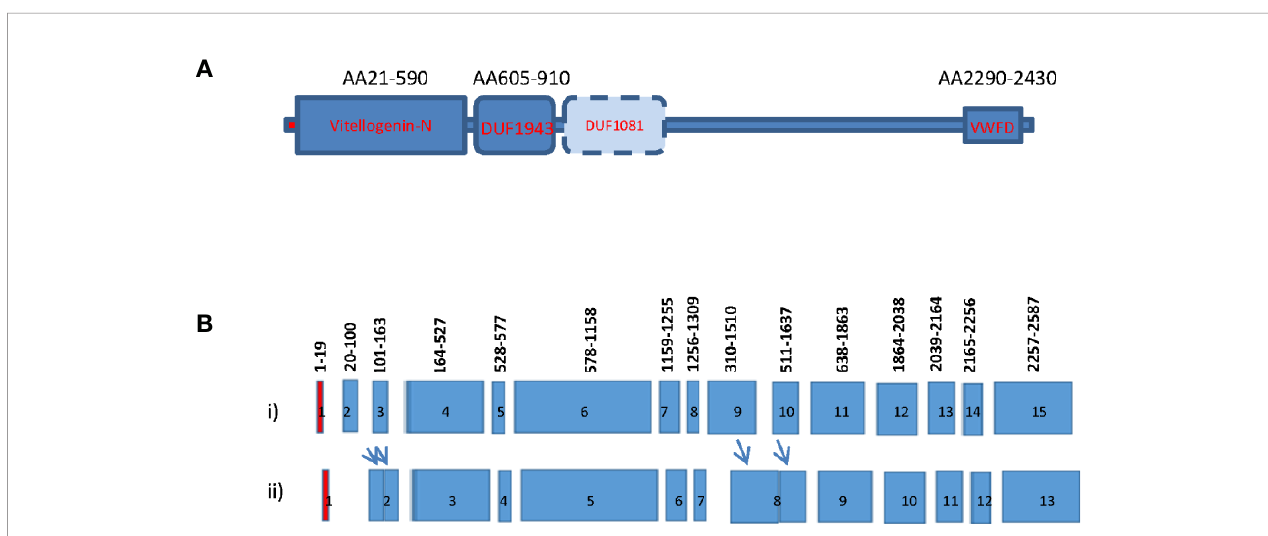
FIGURE 1 | Gene structure and domain organization of vitellogenin of decapod crustaceans. (A) Vitellogenin gene structure of decapod crustaceans. The Vg of crustacean consists of the N-terminal vitellogenin-N domain, a domain of unknown function 1943 (DUF1943), occasionally a domain of unknown function 1081 (DUF1081), and a C-terminal vertebrate Von Willebrand D domain (VWFD) (1 – 2); (B) Intron and exon gene organization of shrimp vitellogenin. Exons are indicated by the colored boxes and introns are represented by gaps between neighboring exons. Most crustacean Vg genes consist of 15 exons interrupted by 14 introns (i). Only a few Vg genes consist of less than 15 exons (ii). The red boxes represent exon1 that encodes for the signal peptide of the Vgs . The numbers above each exon indicate the position of the amino acid encoded by the exons. The relative position of these intron/exon boundaries are also conserved in many reported Vg genes (3 – 4). Arrows indicate fusion of the exons to form a larger